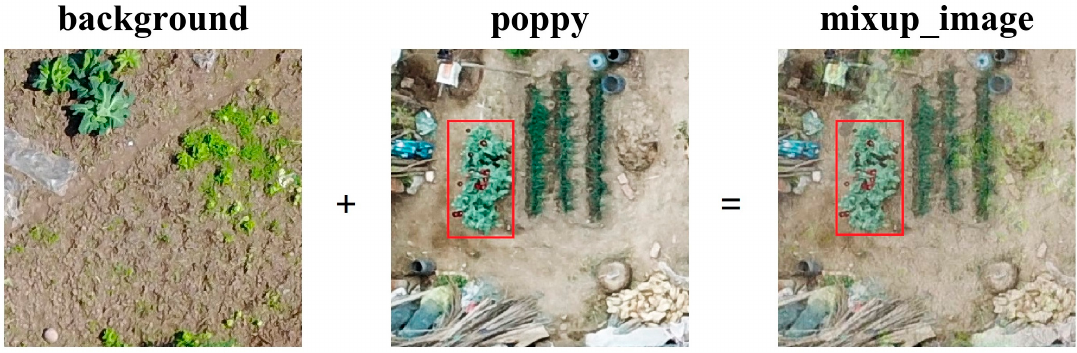
Figure 4. Fused image resulting from synthesizing the background and poppy images, for poppy detection based on the Beta distribution.